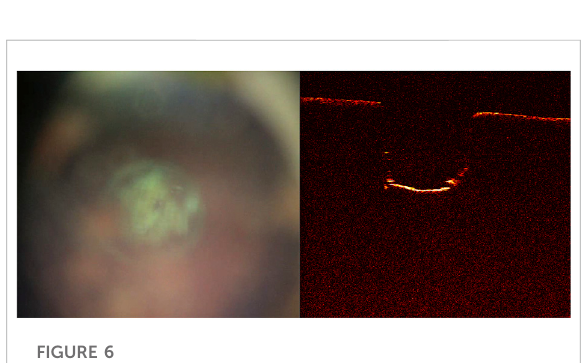
FIGURE 6 Cut-through not yet achieved as shown on the (A)